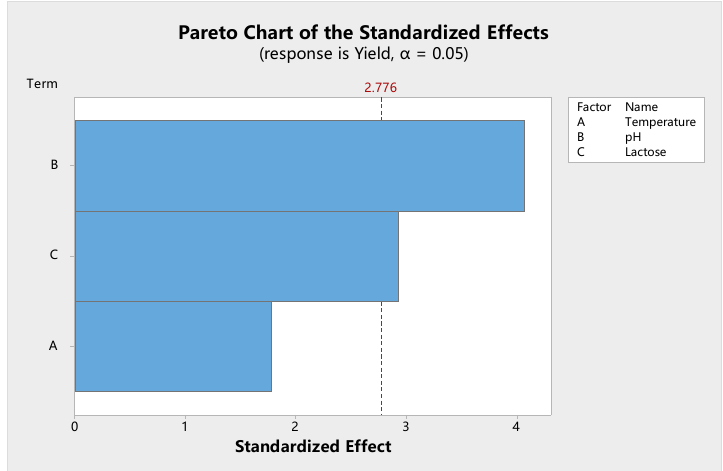
Figure 7. Pareto chart showing the significance of the various factors of models for β -galactosidase activity. Each trial was carried out with three independent experiments, with the results being presented as the mean ± standard deviation. The data were analyzed by Minitab and shown as a Pareto chart. The Pareto chart was determined with 95% confidence from an analysis of variance (ANOVA).